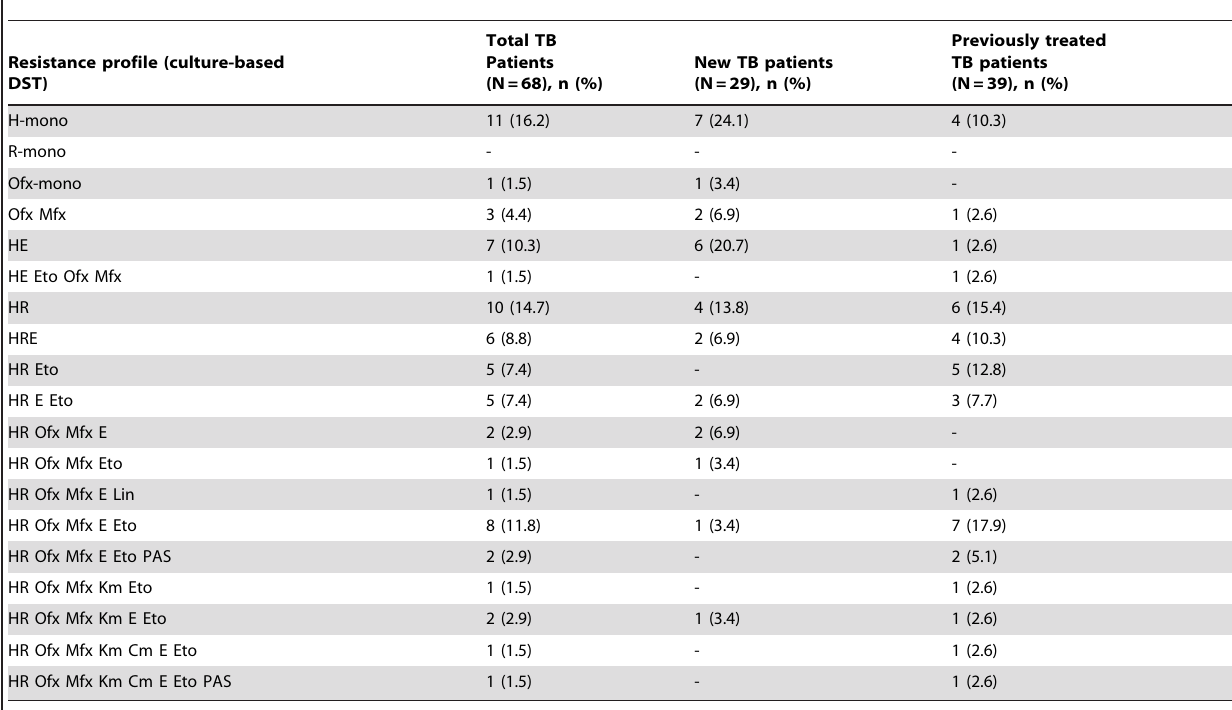
Table 2. Resistance profile (first and second-line) for all drug-resistant tuberculosis patients, Mumbai, India.